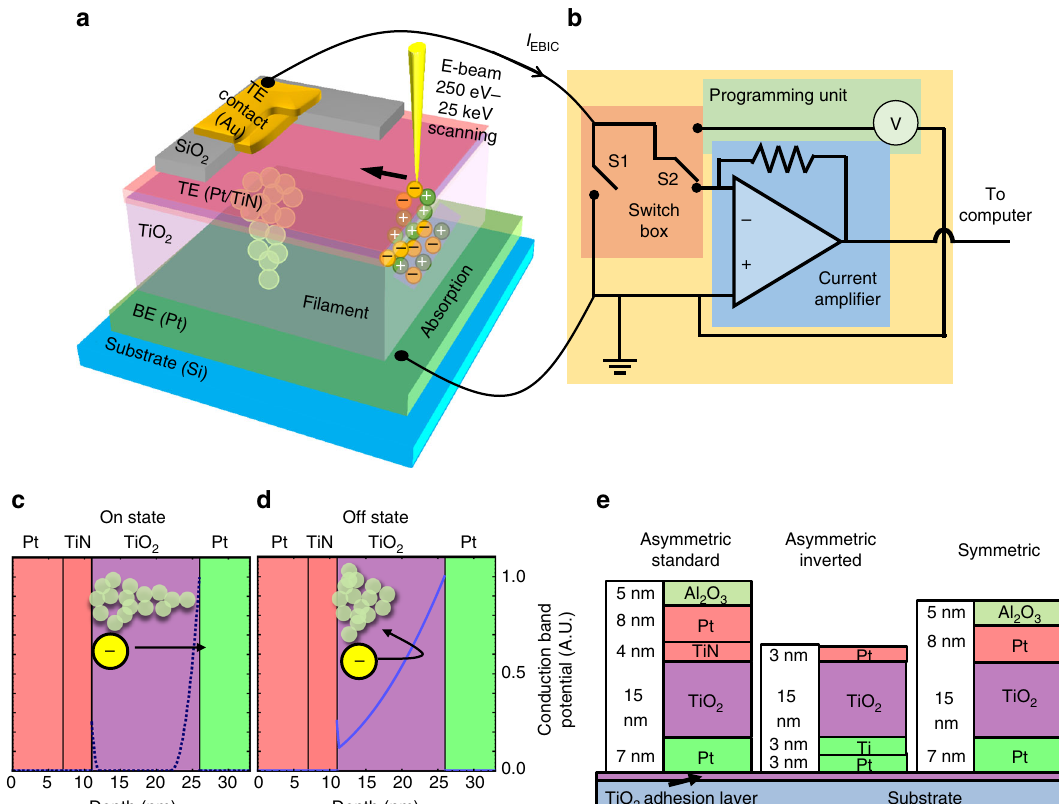
Fig. 1 Overview of experiment. a 3D depiction of the experimental EBIC measurement including top electrode (TE, pink), the TE contact (yellow), bottom electrode (BE, green), e-beam with its generated carriers, dielectric layer (TiO 2 , purple), and the programmable fi lament. b Basic electric measurement setup including switch box with grounding switch (S1) and exchange between imaging (with the current ampli fi er) and programming (S2). c Simpli fi ed schematic depiction of the fi lament in the on state (spanning the top electrode to the bottom electrode) and d the off state (leaving an insulating barrier). e Device stack of the different structures analyzed. The protective aluminum oxide was stripped from the inverted device and the Pt made thinner in an attempt to increase the